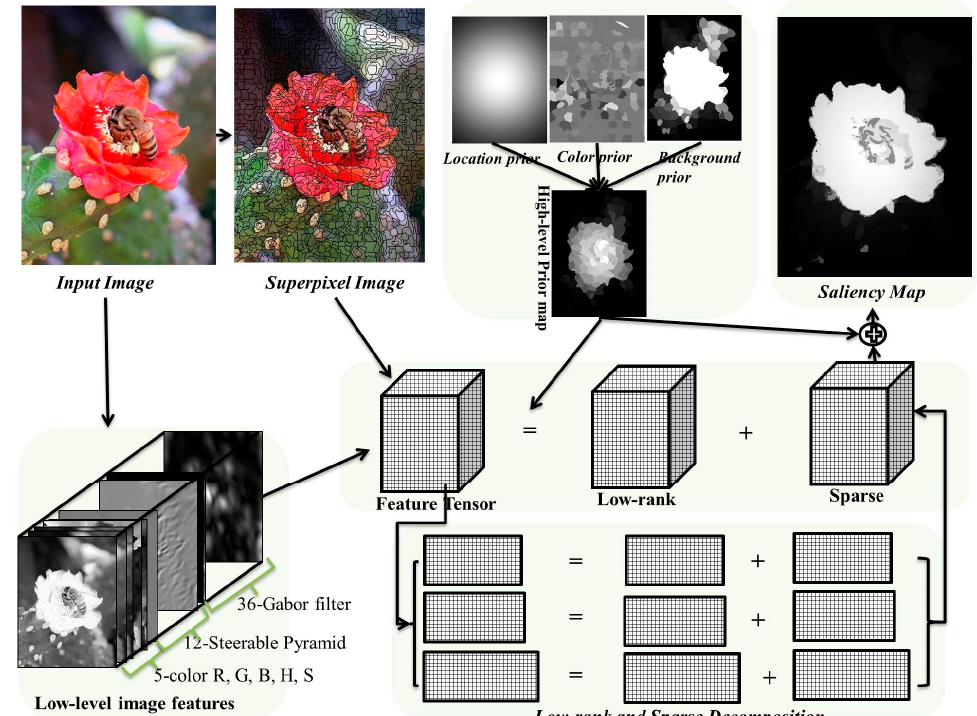
Figure 1. Framework of the tensor decomposition based salient object detection.